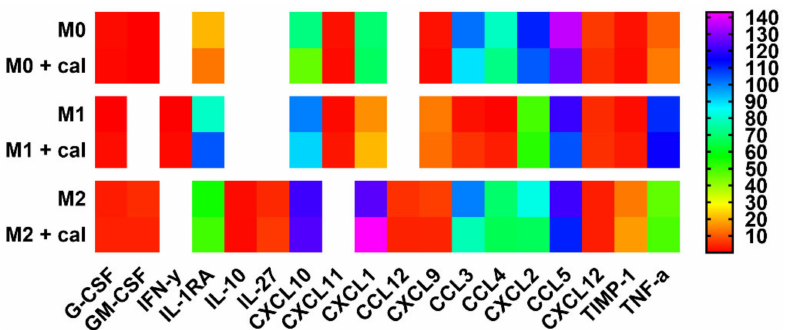
Figure 3. The influence of calcitriol on the production of cytokines and chemokines in the supernatants of BMDMs cultures analyzed by Mouse Cytokine Array Panel A assay. The macrophages M1 and M2 show